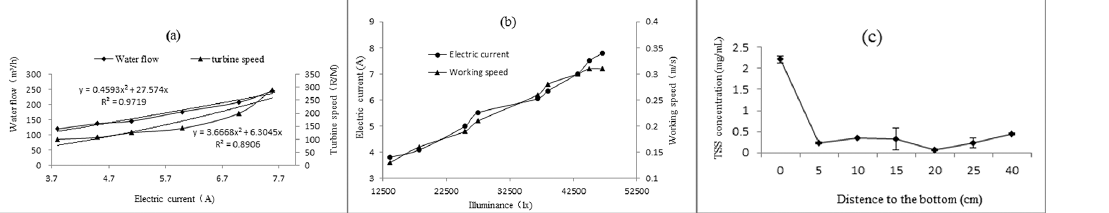
Fig 7. Effect of light intensity and entrance distance on the SMWM. (a) The relationship of illumination with turbine speed and water flow. (b) The relationship of illumination with current output and working speed. (c) The effect of floc sludge absorption relationship of the distance the sediment lifting device to the sediment ’ s